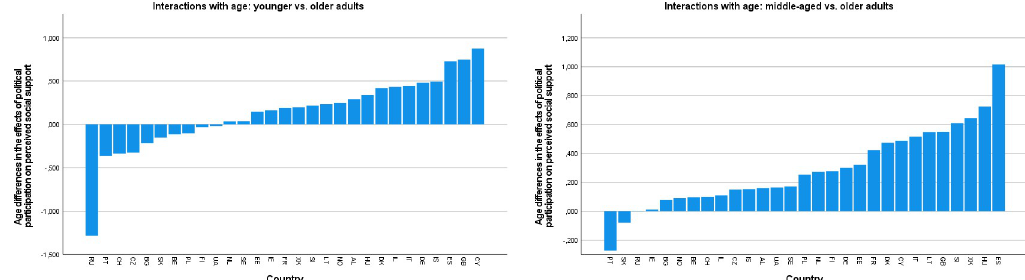
Fig 6. a. Country distribution of the interactions between political participation and age (younger vs. older adults) in relation to perceived social support. b. Country distribution of the interactions between political participation and age (middle-aged vs. older adults) in relation to perceived social